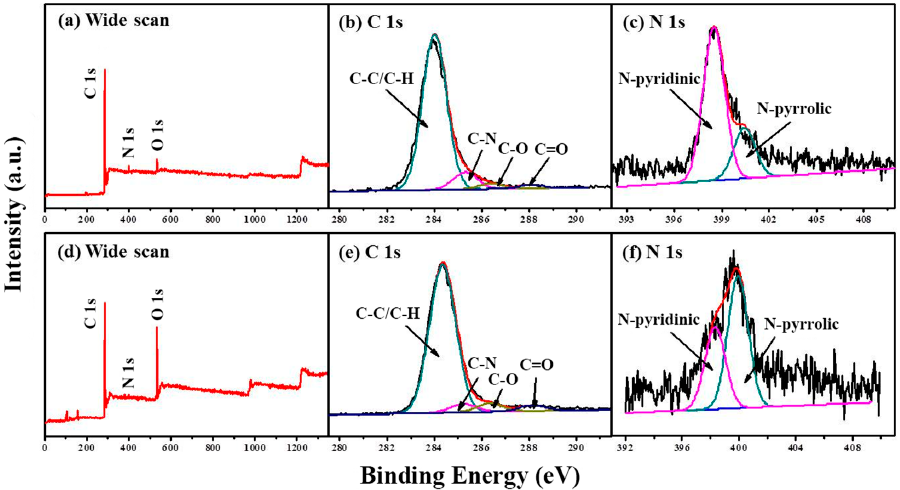
Figure 3. XPS spectra of M/P-0.1: ( a ) wide scan, ( b ) C 1s, and ( c ) N 1s regions. XPS spectra of M/P-0.1-600-2: ( d ) wide scan, ( e ) C 1s, and ( f ) N 1s regions.